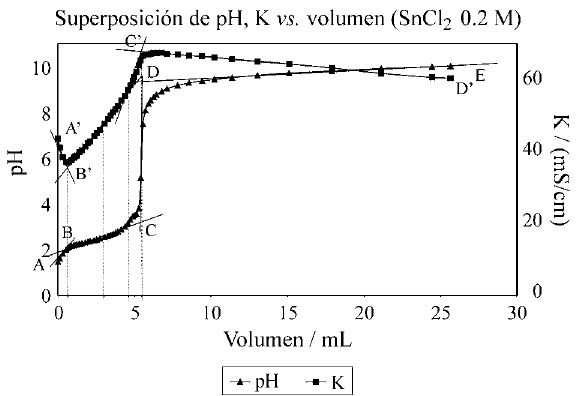
Figura 1a. Curvas potenciométricas y conductrimetricas para una disolu- ción 0.2 M de SnCl 2